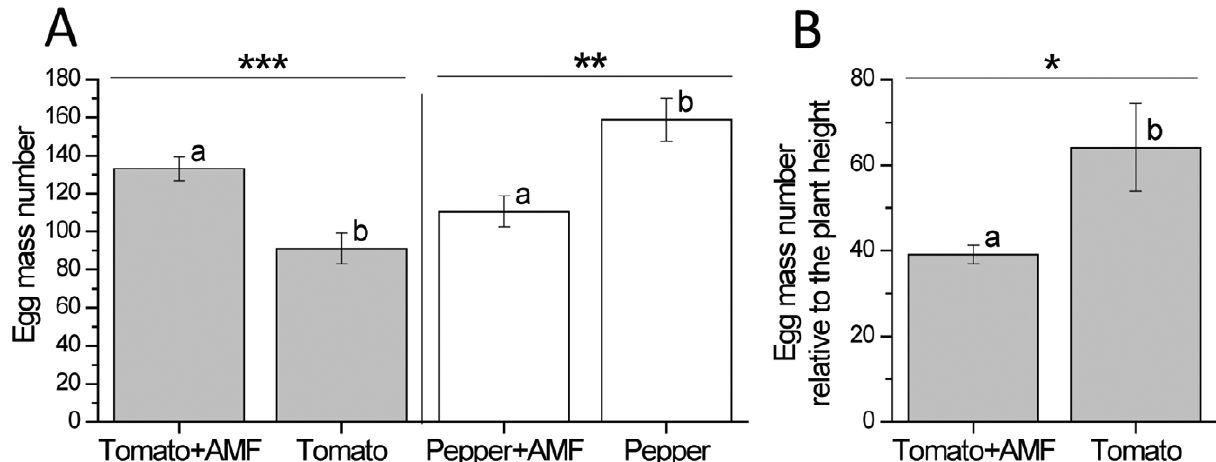
Figure 3. Mean numbers of Meloidogyne incognita egg masses in root segments of tomato or pepper plants (Graph A), and mean numbers of egg masses (normalised to plant height) in root segments of tomato plants (Graph B), with or without AMF inoculation treatments, 6 weeks after inoculations with J2 nematodes. Means accompanied by different letters are significantly different (n ≥ 9: P < 0.05 (*), 0.01 (**) or 0.001 (***), Student’s